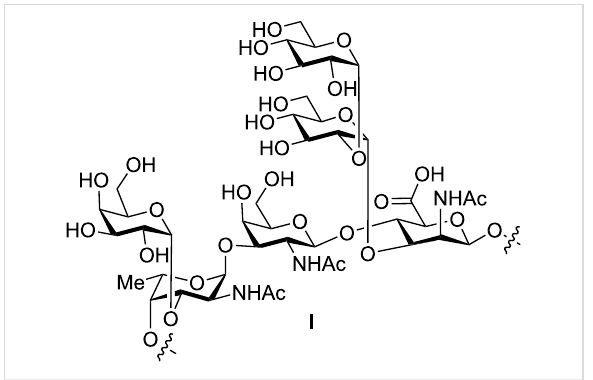
Figure 1: Structure of the S. pneumoniae serotype 12F capsular poly- saccharide repeating unit [15].